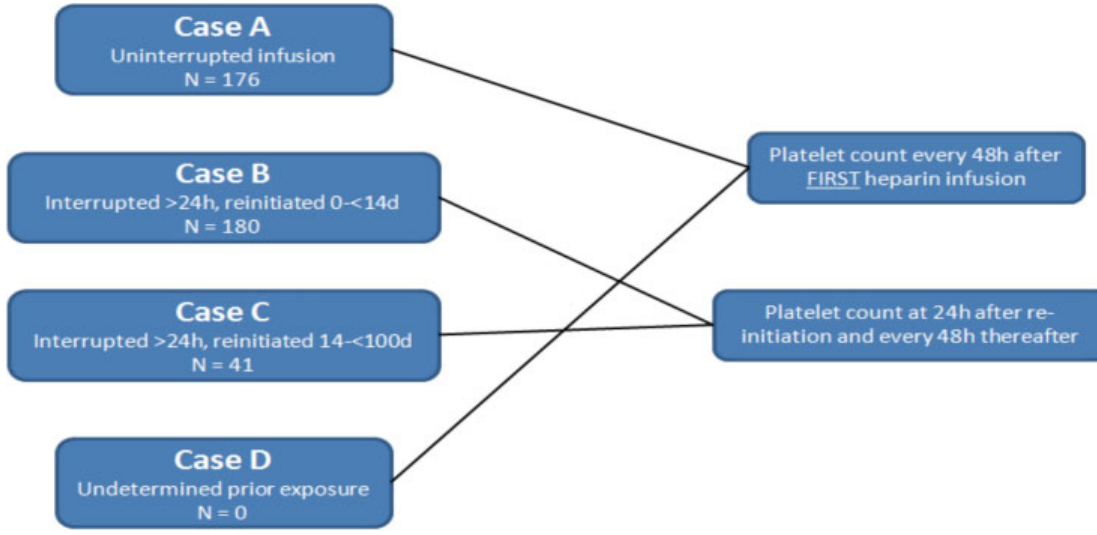
Fig. 1 Platelet monitoring algorithm based on prior heparin exposure. Case A represents a continuous heparin infusion, with platelet counts monitored every 48 hours. Case B represents a stop in heparin infusion > 24 hours and < 14 days. Case C represents a stop in heparin infusion followed by a restart after 14 days. Case D was unknown exposure